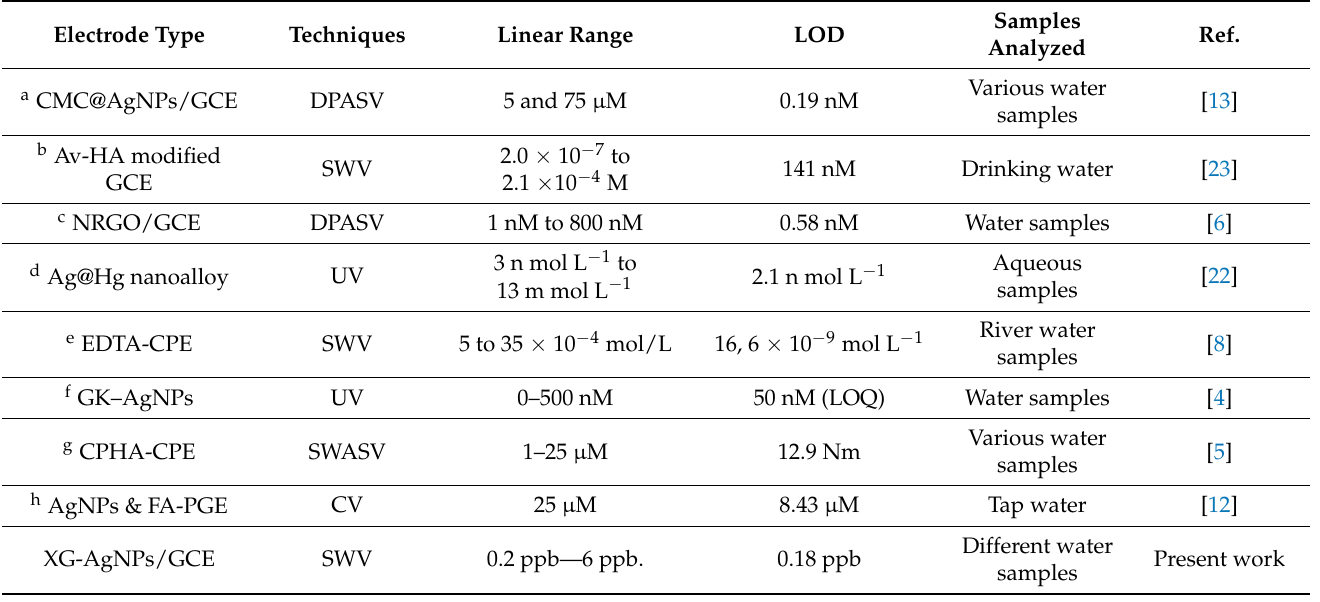
Table 1. Comparison of the analytical performance obtained at XG-AgNPs/GCE with different electrodes reported in the literature for the electrochemical determination of Hg 2+ .